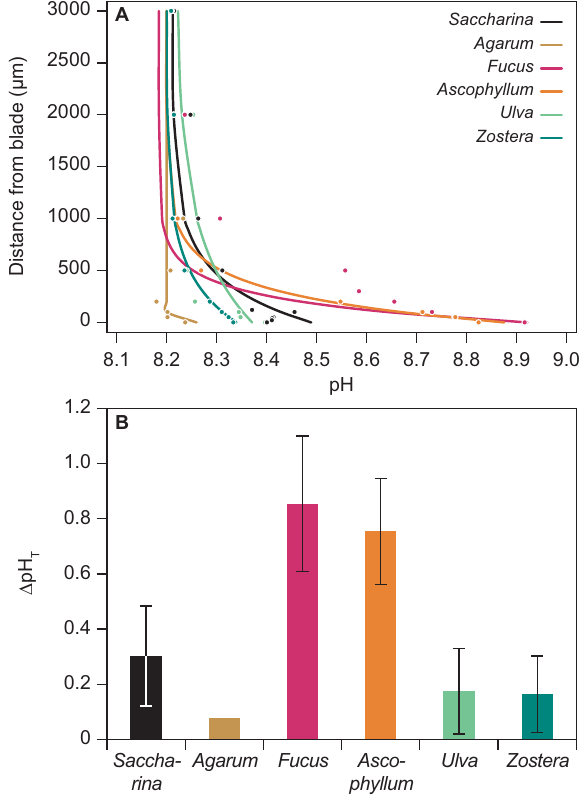
Figure 9. O 2 concentration and pH in vegetated tidal pools and in surface waters of neighbouring vegetated intertidal shores measured at low tide during day and night just after pool formation and before pool